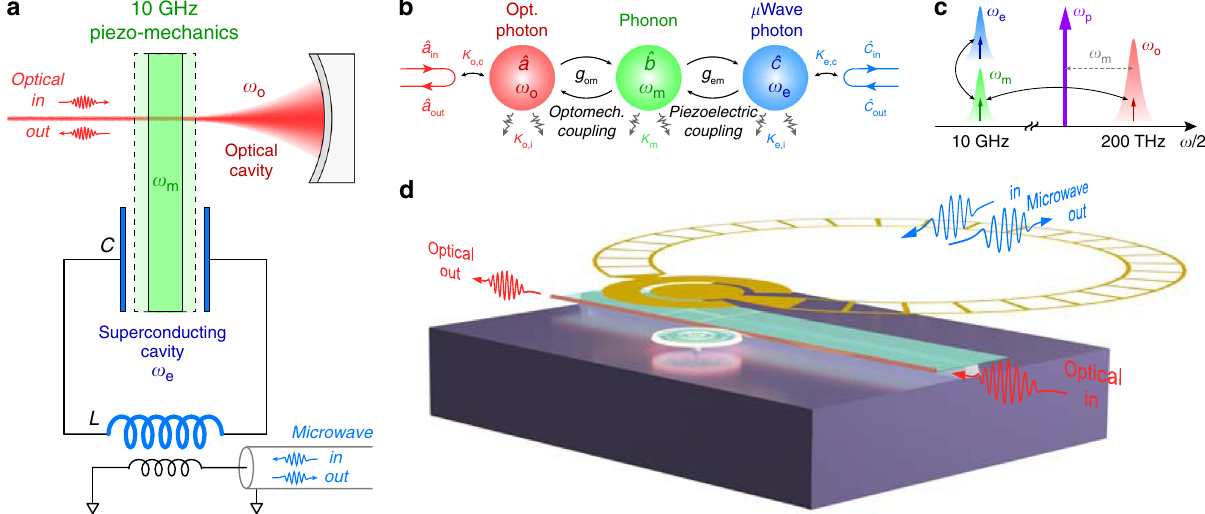
Fig. 1 Superconducting cavity piezo-optomechanical system. a A schematic of a 10-GHz mechanical resonator simultaneously coupled with an optical cavity and a superconducting cavity to achieve resonantly enhanced optomechanical and electromechanical interactions at the same time. The superconducting cavity is inductively coupled to a transmission line for microwave signal input and output. b Interaction diagram of the triple-resonance system. g em and g om denote the electromechanical and the cavity-enhanced optomechanical coupling rates, respectively. c Photon conversion mechanism in the frequency domain. The blue, green, and red Lorentzian shapes stand for the microwave, mechanical, and optical resonances, respectively. A red- detuned optical pump is indicated as the purple arrow. d Experimental realization of the triply resonant superconducting piezo-optomechancial interface (schematic not to scale). A frequency-tunable superconducting “ Ouroboros ” microwave resonator (yellow) is aligned and coupled with a piezo- optomechanical micro-disk through the piezoelectric effect. Microwave and optical photons are interconverted via cavity-enhanced interactions with 10-GHz phonons supported by the thickness mode of the